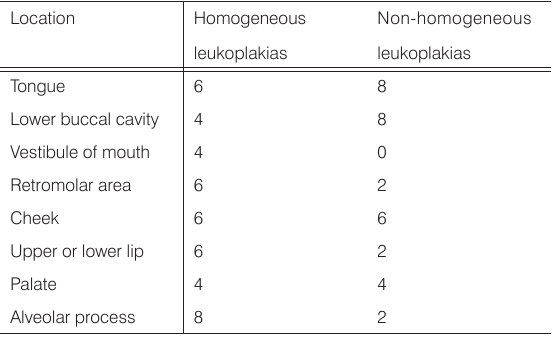
Table 2. Homogenious versus non-homogenious leukoplakias